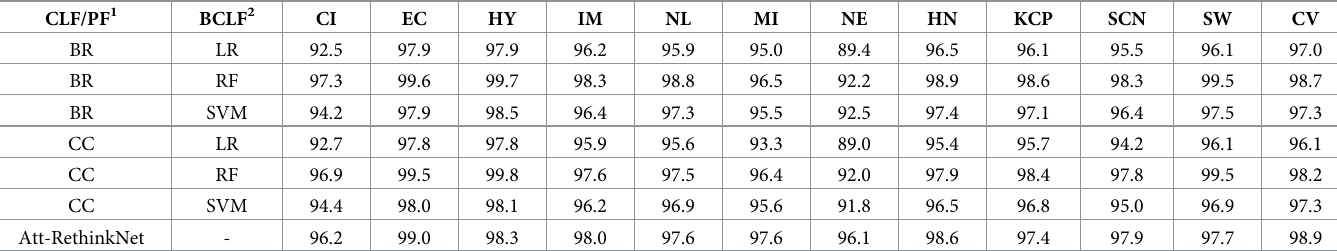
Table 8. Performance of all pathological findings for BR, CC and Att-RethinkNet in liver data. CLF/PF 1